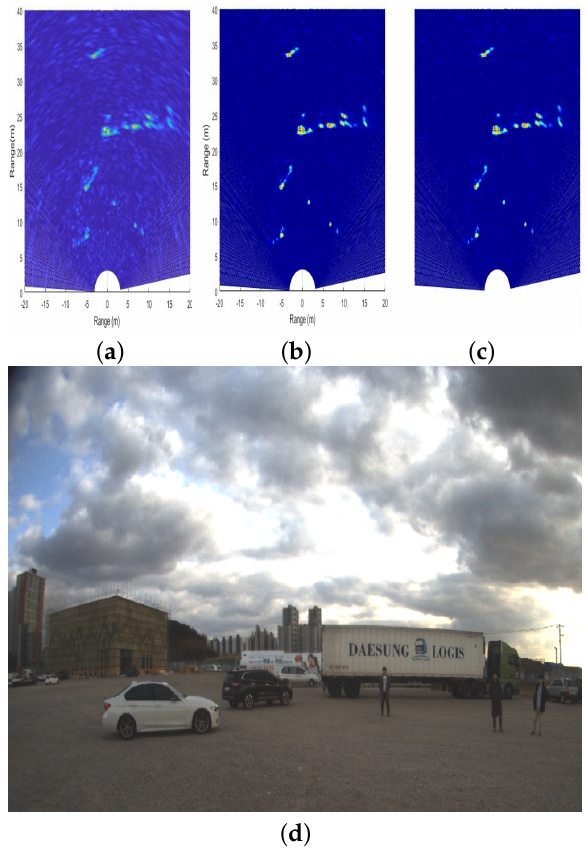
Figure 2. Preprocessing for the input radar image for YOLO network: ( a ) radar image converted into the Cartesian coordinate system; ( b ) radar image after applying the color rule; ( c ) final radar image input to the YOLO network; and ( d ) corresponding camera